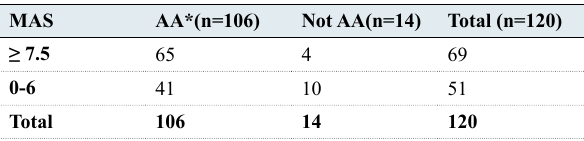
Figure 3: ROC curve for RIPASA Score The area under the ROC curves was calculated for both MAS and RIPASA scores. The area was 0.723 for MAS (fig. 2) and 0.772 for RIPASA (fig.3) score demonstrating a higher discriminatory power for RIPASA score when compared to MAS (p-value: 0.001 vs. 0.007).